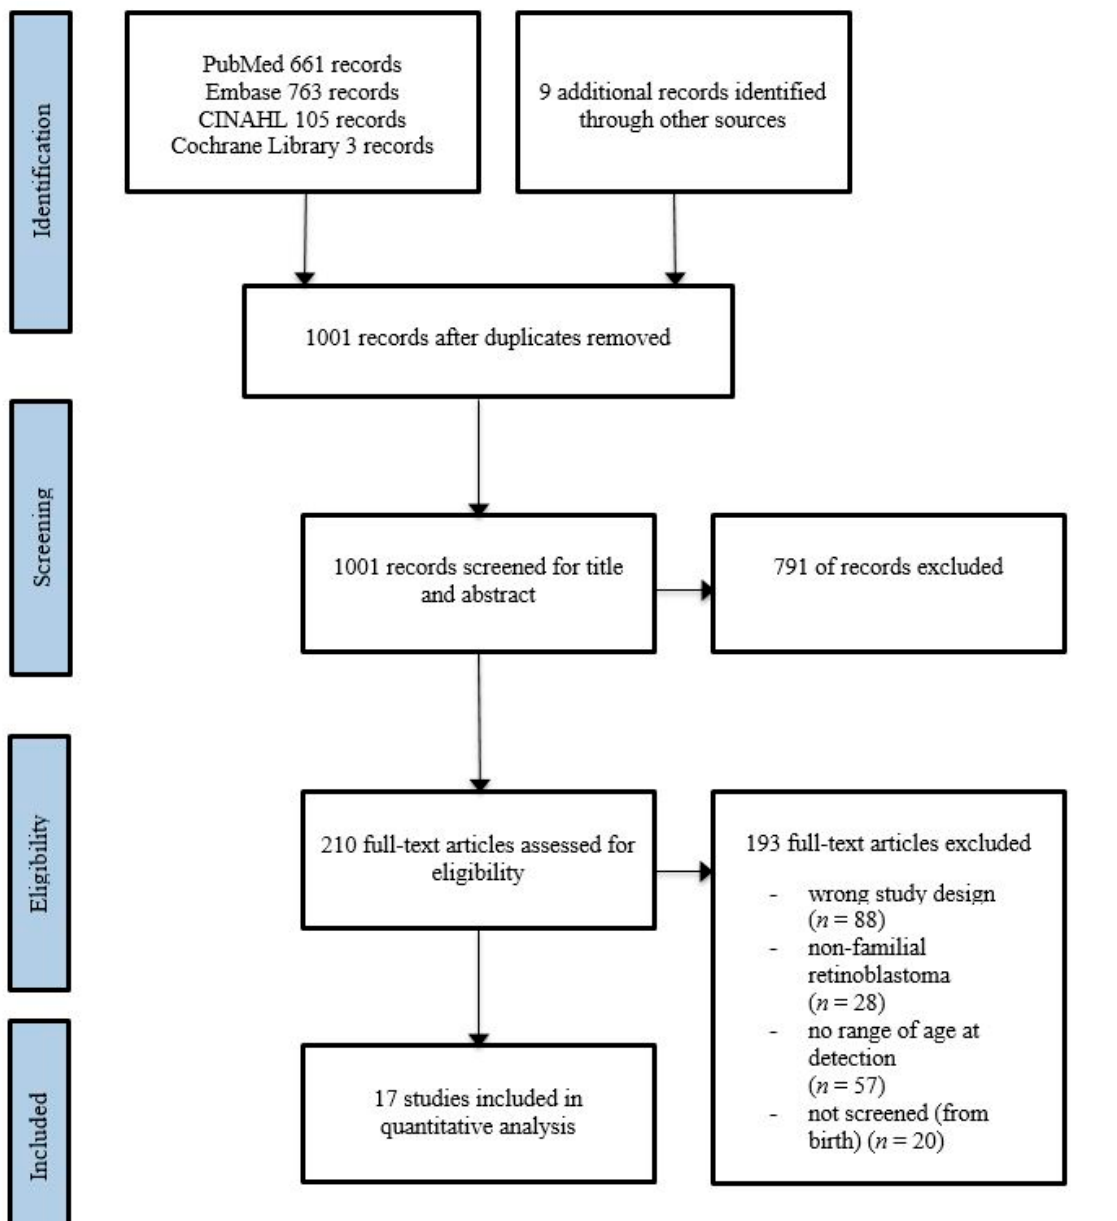
Figure 1. Flow diagram of the study inclusion process.